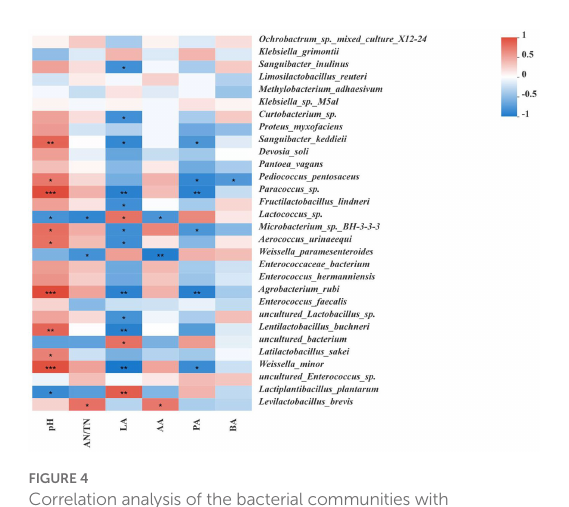
FIGURE 4 Correlation analysis of the bacterial communities with fermentation characteristics. Fermentation characteristics are displayed vertically and the bacterial community information is displayed horizontally. The corresponding values displayed in the heat map are the Spearman correlation coefficients r, which range between − 1 and 1; r < 0 indicates a negative correlation (blue), r > 0 indicates a positive correction (red), and ‘*,’ ‘**,’ and ‘***’ represent p < 0.05, p < 0.01, and p < 0.001,